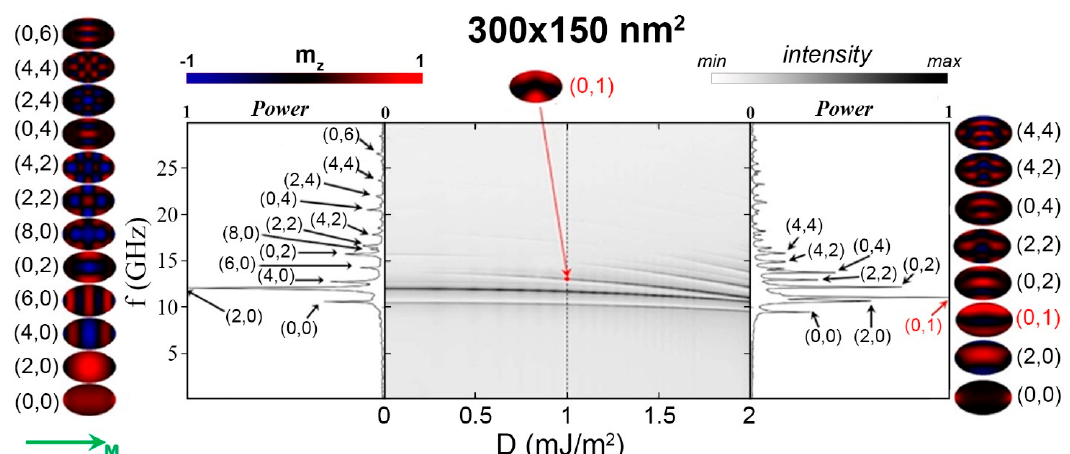
Figure 5. Central panel: dependence of the frequencies of the spin wave eigenmodes on the DMI constant D for the elliptical dot of lateral dimensions 300 × 150 nm 2 . On the left- and right-hand sides, the intensity spectra corresponding to D = 0 and 2 mJ/m 2 are reported, respectively, together with the color insets that represent the spatial profile of the dynamical magnetization, expressed as the product of the modulus of the dynamical magnetization by the sign of its phase. The animations with the movies of the dynamics of all the modes for several values of D are available in the Supplemental Material.